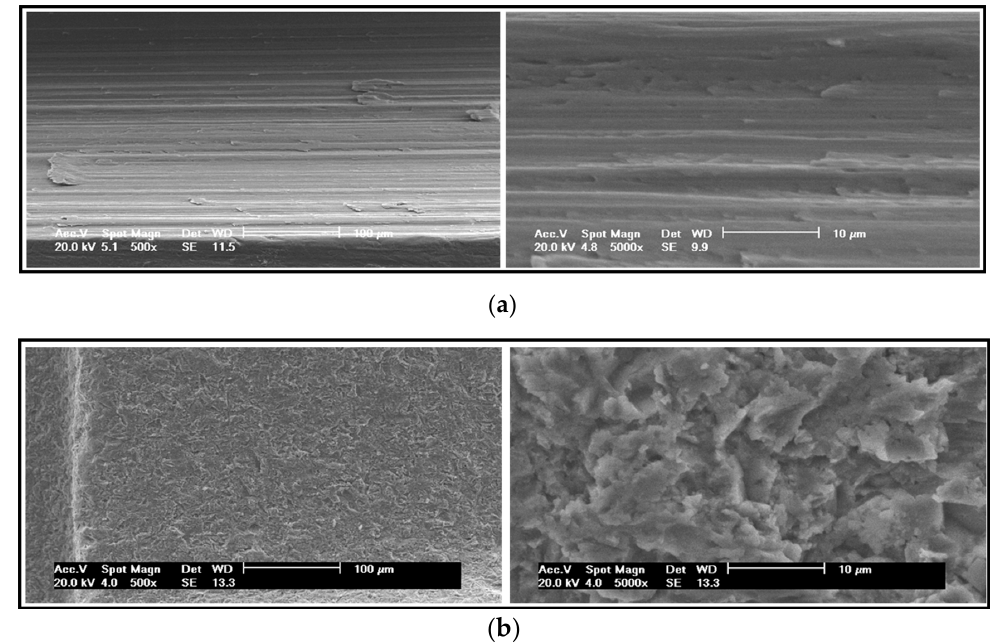
Figure 3. Representative SEM images of the two surface models used in both implant macrogeometry: ( a ) Without treatment (machined surface) and ( b ) with surface treatment.